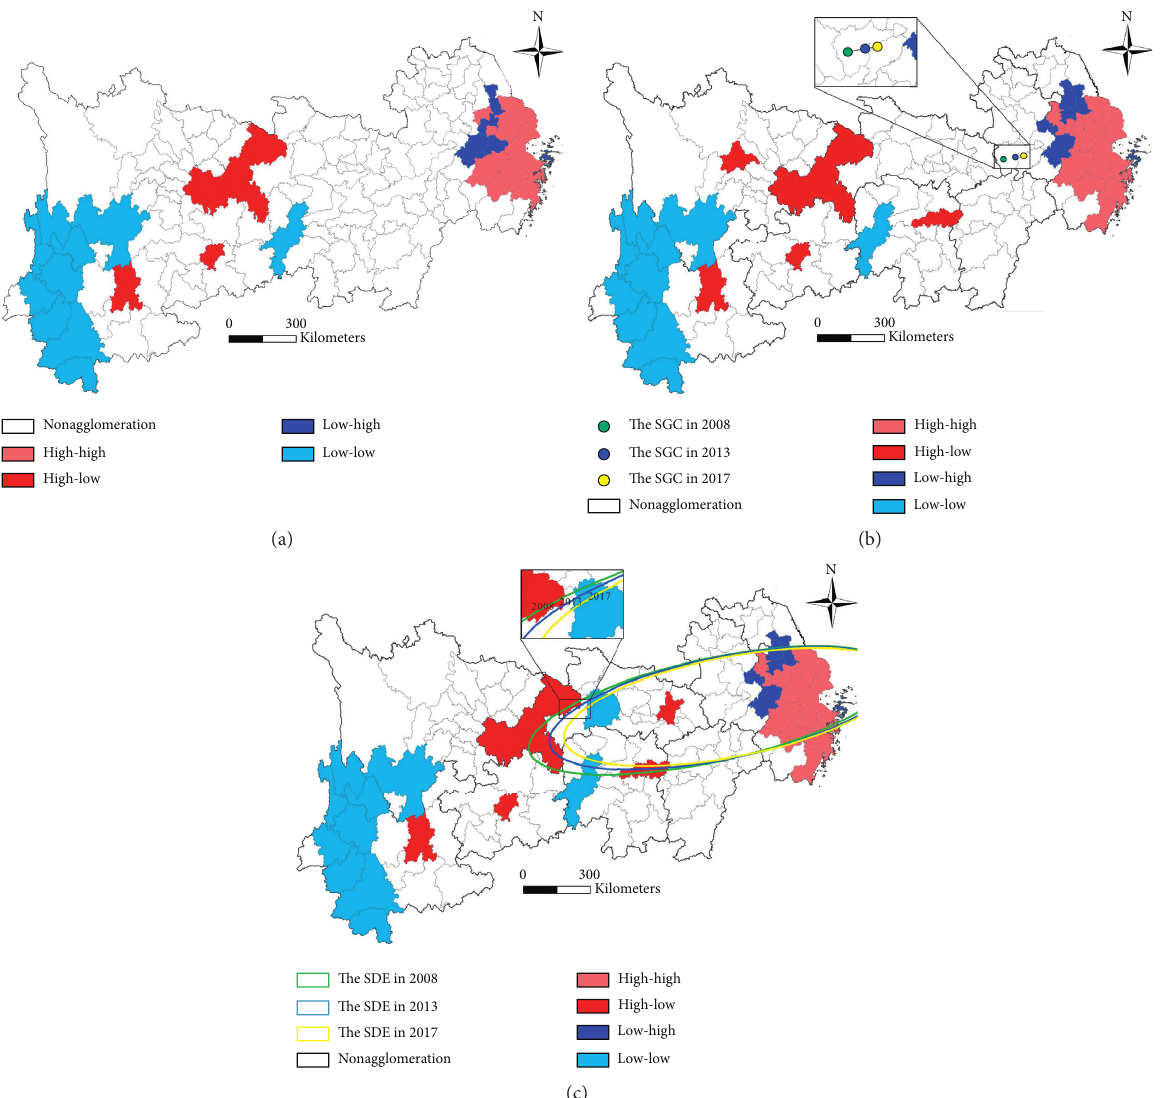
Figure 7: The spatial agglomeration classification, spatial gravity center (SGC), and standard deviation ellipse (SDE) of listed companies in the YEB region for (a) 2008, (b) 2013, and (c)